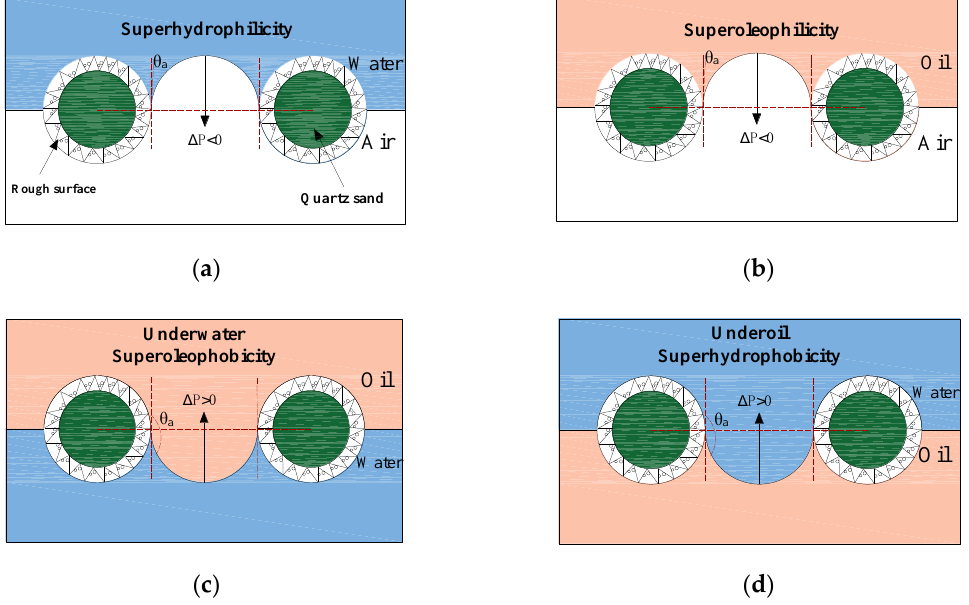
Figure 12. Theoretical wetting model of superhydrophilic and underwater superoleophobic or superoleophilic and underoil superhydrophobic filter media. ( a ) In air, water can pass through superhydrophilic quartz sand; ( b ) in air, oil can pass through superoleophilic quartz sand; ( c ) underwater, oil cannot pass through underwater superhydrophobic quartz sand; ( d ) under oil, water cannot pass through underoil superhydrophobic quartz sand.